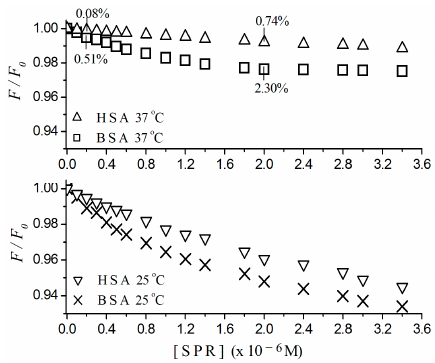
Figure 1. Normalized fluorescence quenching plots of human serum albumin (HSA) and bovine serum albumin (BSA) titrated with sulpiride at 25 and 37 °C. Excitation λ = 290 nm; [albumin] = 2 × 10 ´ 6 M; 10 ´ 3 M phosphate buffer, pH 7.4. [SPR] = sulpiride